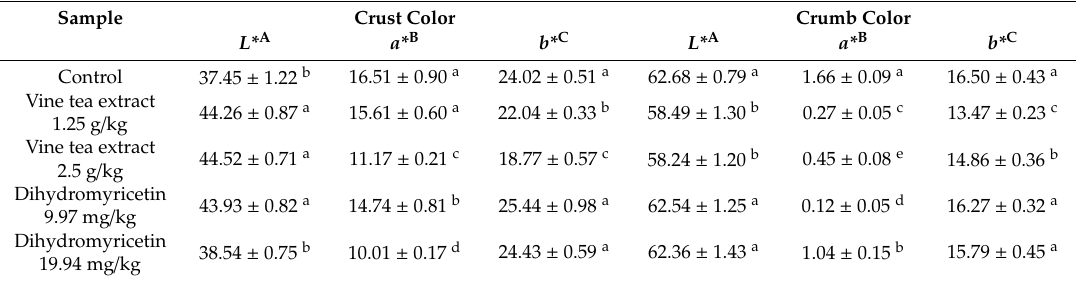
Results of color parameters of breads treated with or without vine tea extracts or